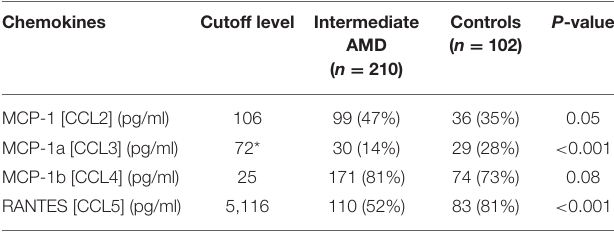
TABLE 3 | Chemokine cutoff levels from ROC curve analysis for discriminating between cases with intermediate AMD and controls. Chemokines